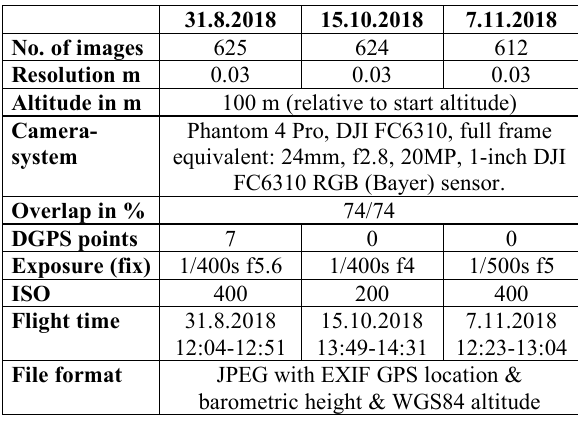
Table 1: Hainich flight plan information for the August, September and November flights over the “Huss”-area.